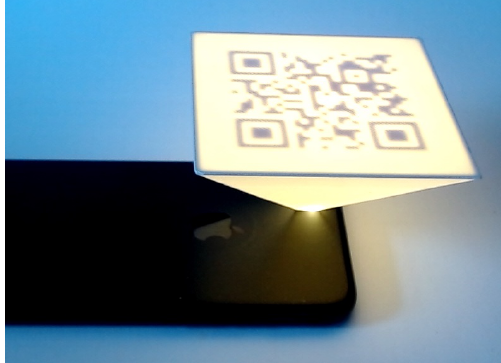
Figure 3. Hidden QR code at the base of the